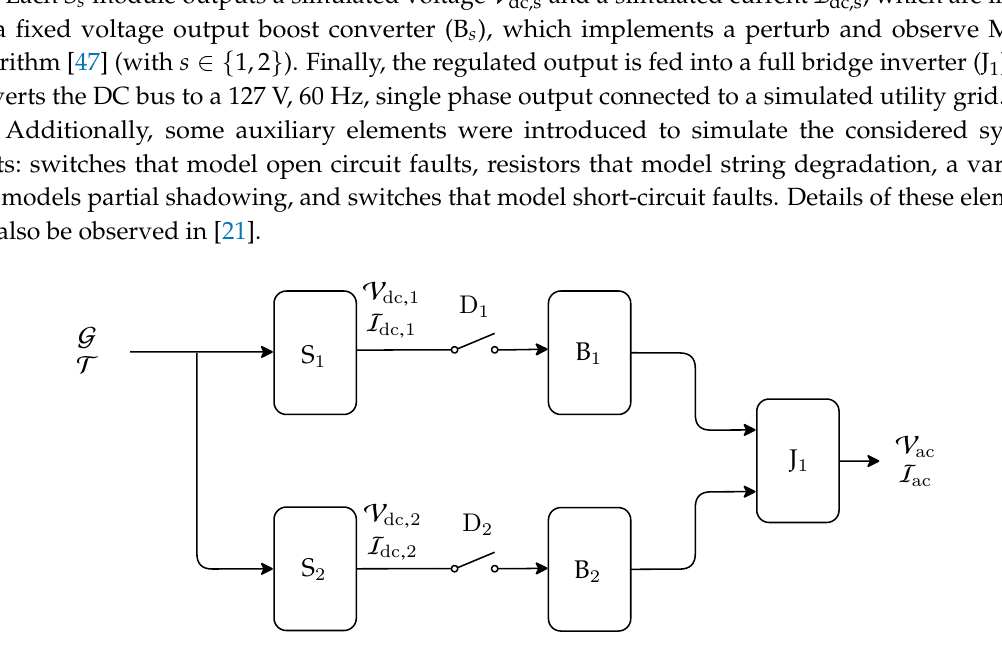
Figure 8: The proposed method consists in transmitting a frame using ⌈ α n cha ⌉ channel uses for the fi rst trans- Figure 7. Photovoltaic Simulator System mission attempt, with 0 < α ≤ 1 . In the event of a decoding error, incremental redundancy is transmitted 1 − α n cha ⌋ channel uses. making use of the rest of the available ⌊ ( )